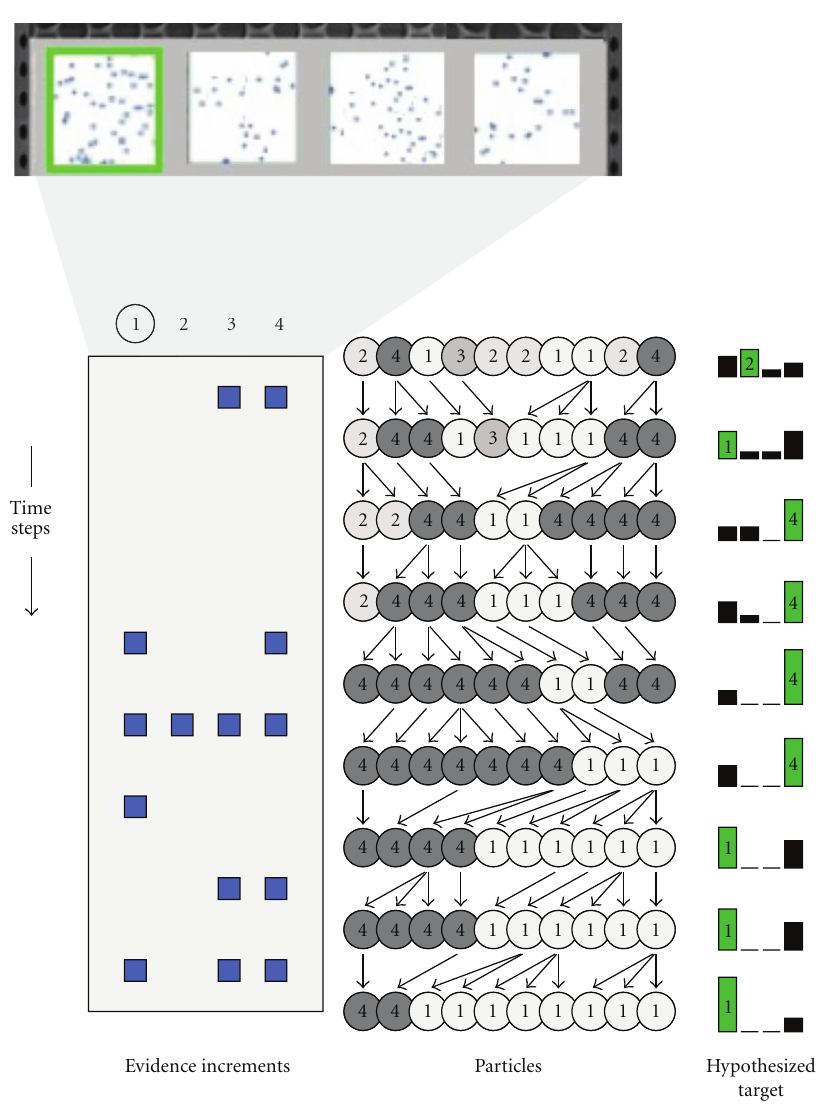
Figure 5: Example of how the particle filter incorporates new evidence on each frame (Figure adapted from Hawkins et al. [29]). Note how the player tracks evidence adjusting their belief at each time step. The number of particles in the model relate to the player’s ability to do this tracking. Players will make a choice about the target when evidence exceeds some decision threshold. The amount of evidence required is related to the players risk